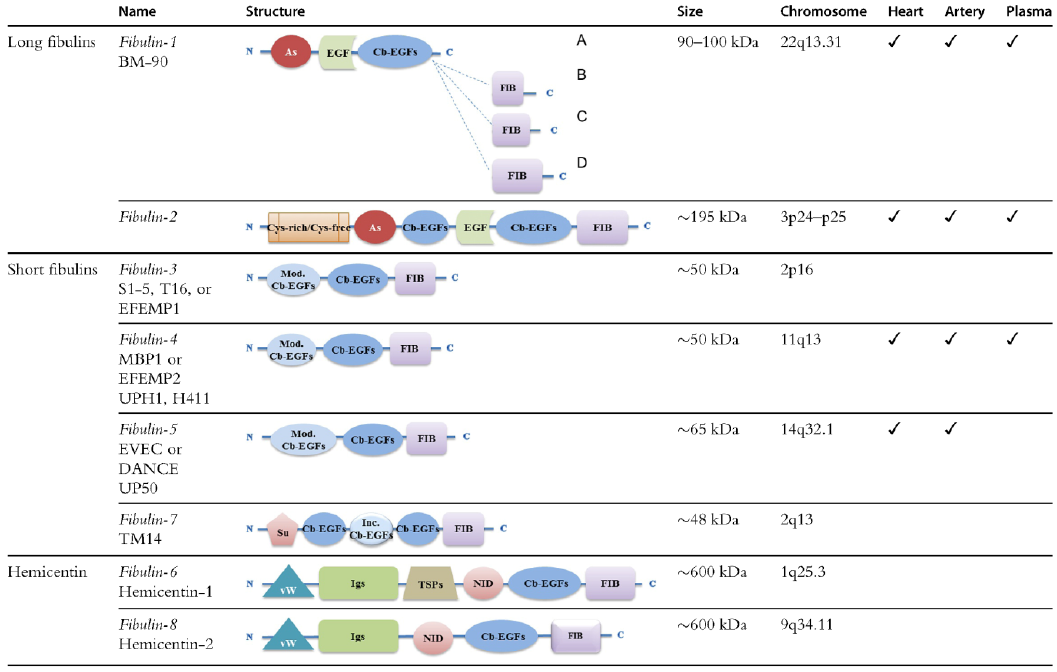
Figure 1. Structure, chromosome localization, and expression of the fibulins [32]. From Cangemi et al. “Fibulins and their role in cardiovascular biology and disease”, Adv Clin Chem 2014, 67; 245–265.